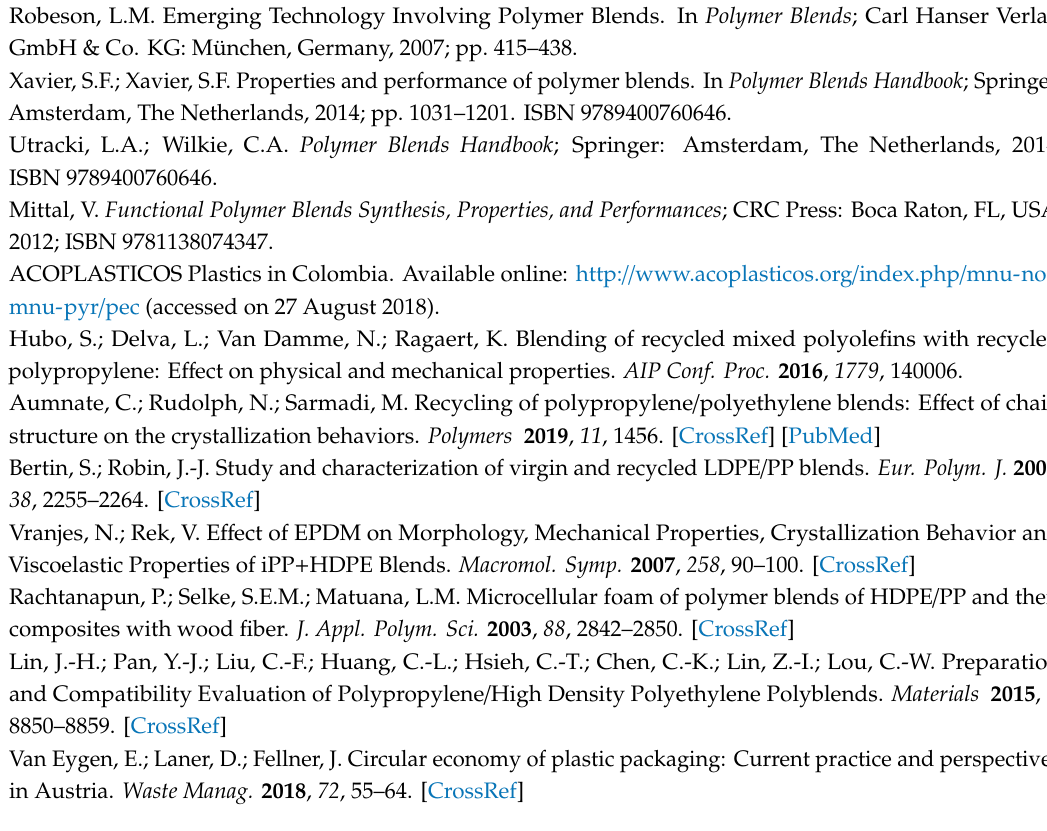
Table S1: Thermogravimetric data of the studied materials, Table S2: Mechanical properties of the studied materials, Table S3: Di ff erential scanning calorimetry data of the studied materials, Table S4: DMA results of the studied materials, Table S5: Linear shrinkage of injected specimens at flow (Sf) and transverse (St)